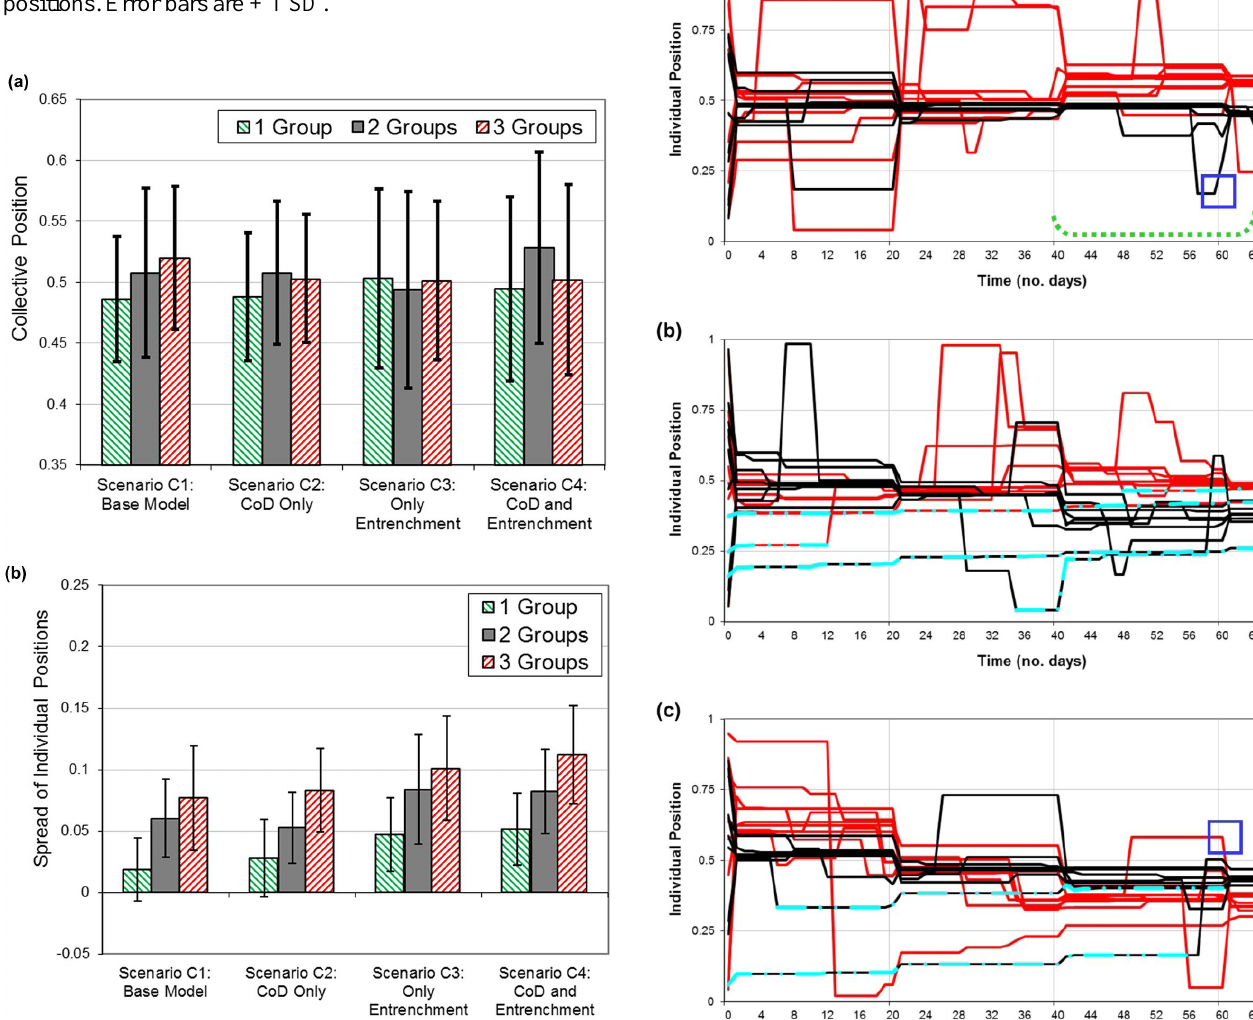
Fig. 9 . Effect of the cost of dissent (CoD) and entrenchment on: (a) collective position and (b) spread of individual positions. Error bars are + 1 SD.